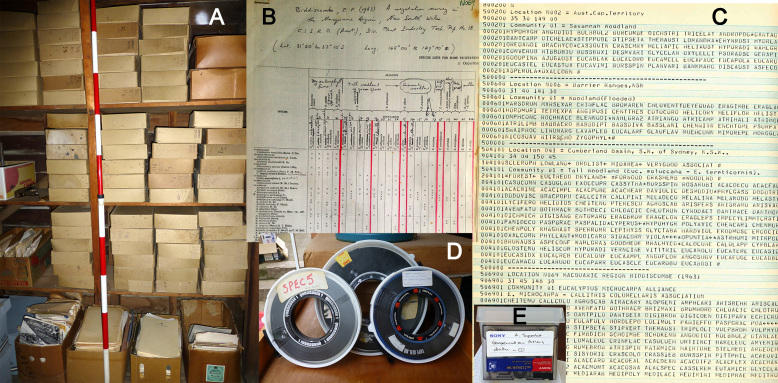
Illustration of the data resources available to the retrieval project: (i) a sample of the boxes of original copies of papers and reports (A), (ii) a table extracted from a publication prepared for data entry (B), (iii) a sample of the hard copy printouts showing alphanumeric lists of species under each location and community (C), (iv) the magnetic tapes on which backups were kept from day to day during the 1980s project (D), and (v) an exabyte tape on to which the data from the magnetic tapes were transferred in 1991 (E).